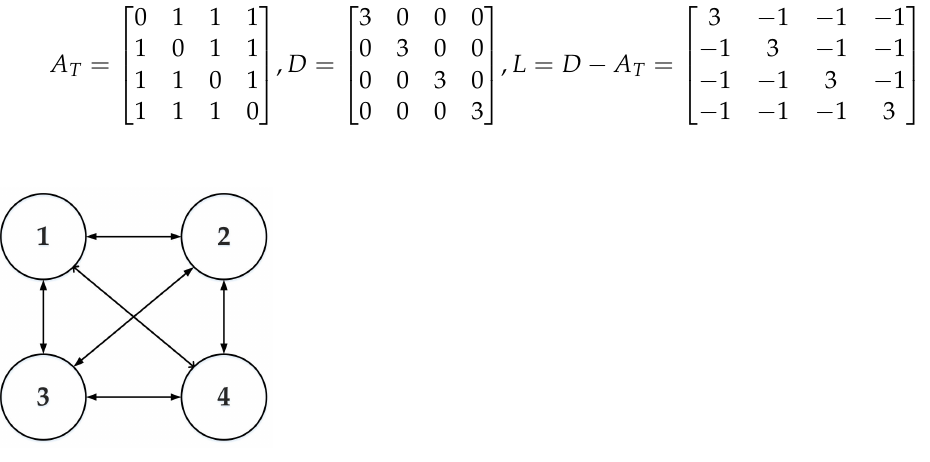
Figure 3. Multi-agent system